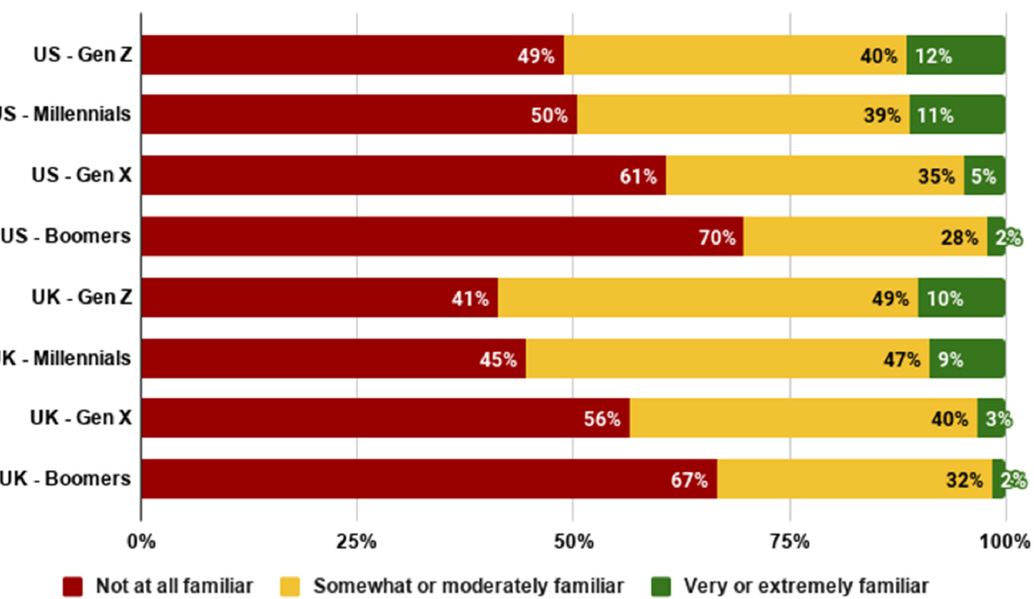
Figure 2. Familiarity with cultivated meat among the general and early majority US and UK populations. As shown in Figure 3, familiarity with cultivated meat was higher amongst younger generations. Over 10% of Gen Z in both countries stated that they were very or extremely familiar with the concept, whilst around two thirds of Boomers were not at all familiar with cultivated meat.